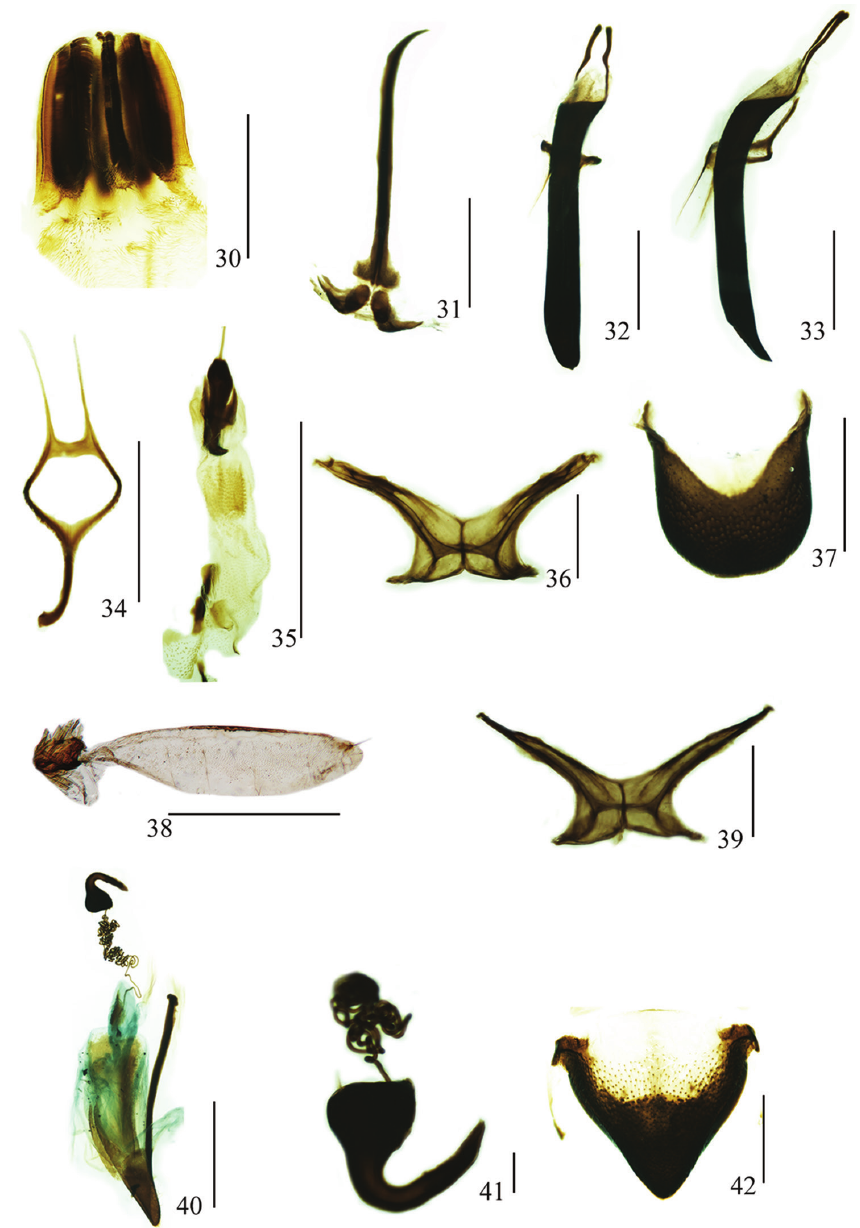
Figures 30–42. Geotragus granulatus (Chao, 1980): 30 male, proventriculus 31 male, sternites VIII and IX, dorsal view 32 aedeagus, dorsal view 33 aedeagus, lateral view 34 tegmen, dorsal view 35 endophallus, dorsal view 36 male, metendosternite, dorsal view 37 male, pygidium, dorsal view 38 male, hind wing, dorsal view 39 female, metendosternite, dorsal view 40 female, sternite VIII and genitalia, lateral view 41 spermatheca, lateral view 42 female, pygidium, dorsal view. Scale bars: 31–35, 37, 38, 40 : 1 mm; 30, 36, 39, 42 : 0.5 mm; 41 : 0.1